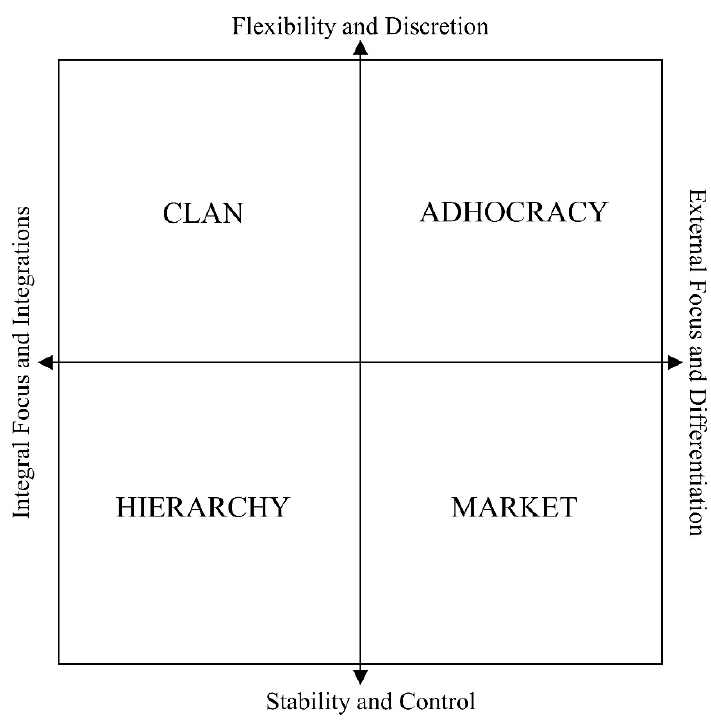
Figure 1. The framework of values of competition, extracted from Cameron and Quinn (2006).